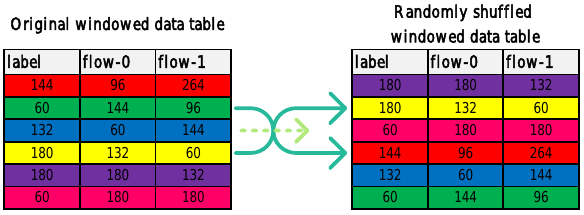
Figure 5. An example of random shuffling of windowed data